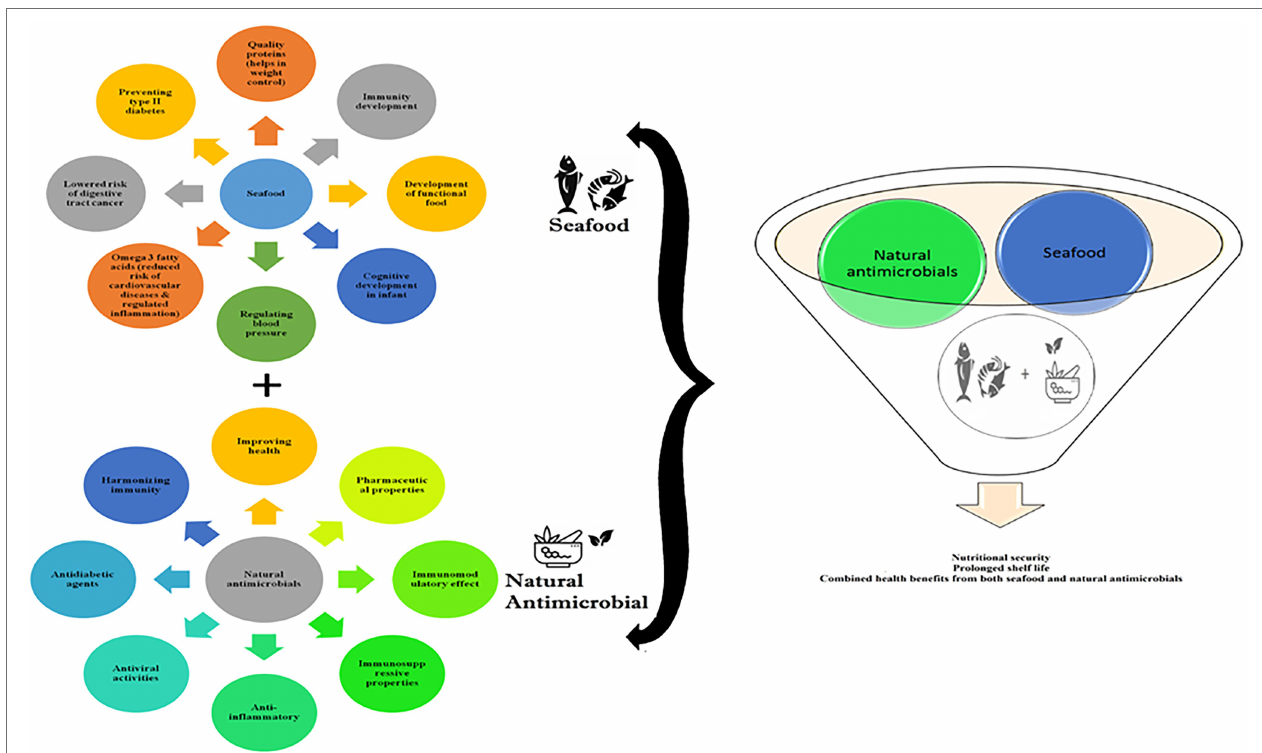
FIGURE 3 | Health promoting benefits of seafood and natural antimicrobial.